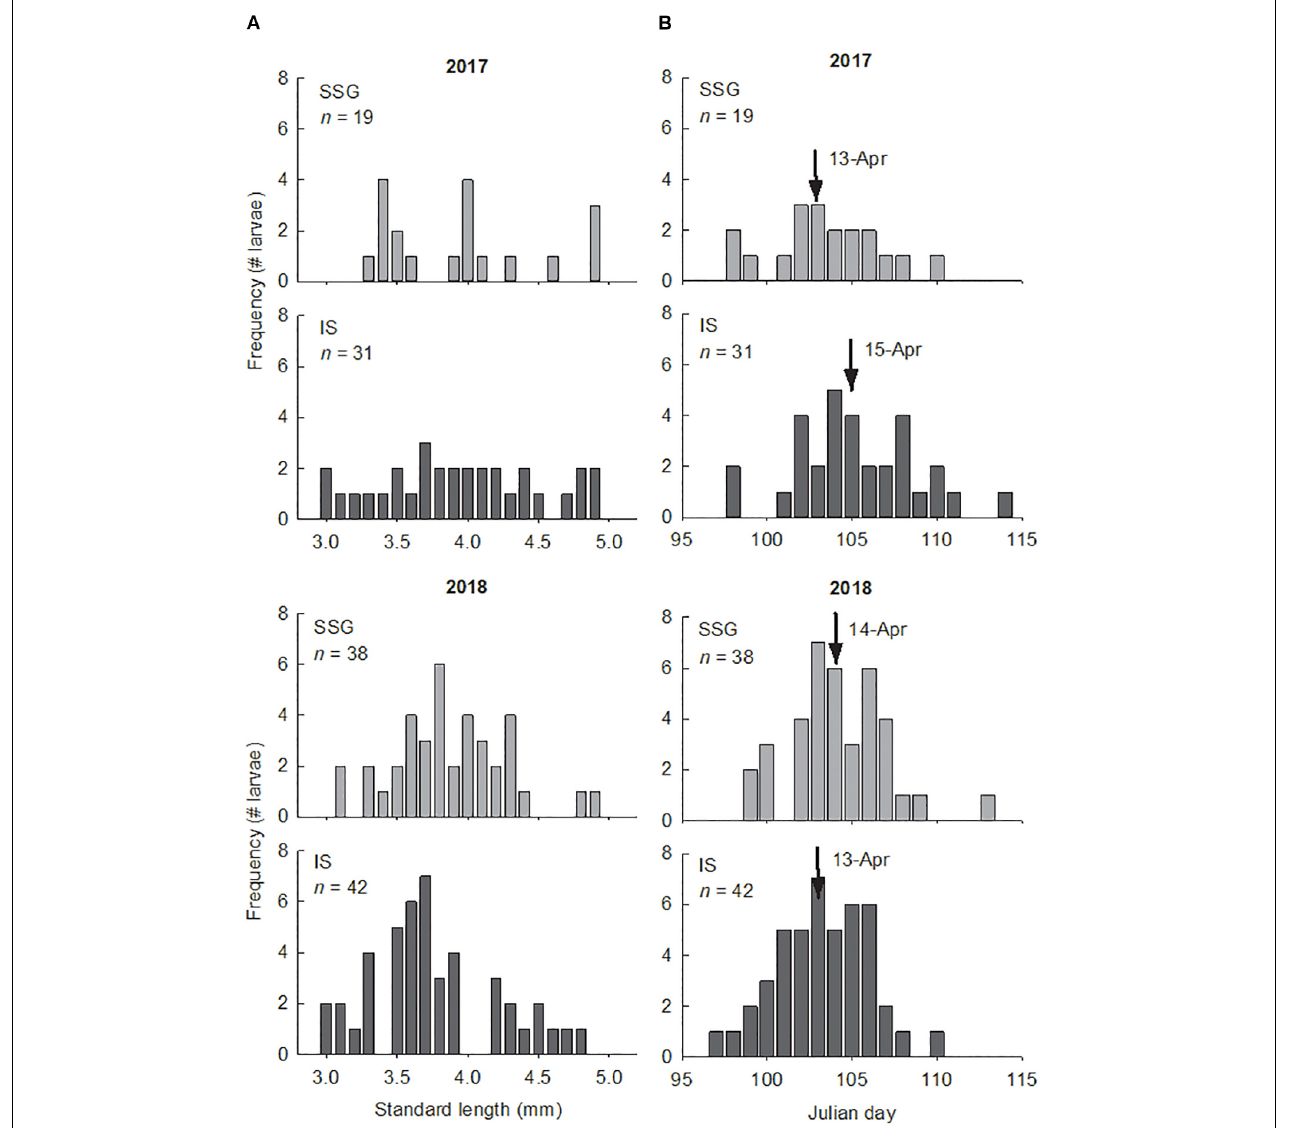
FIGURE 7 | (A) Length frequency distributions of King George whiting larvae from Southern Spencer Gulf (SSG) and Investigator Strait (IS) in 2017 and 2018. Size was constrained to larvae of ≤ 5 mm SL. (B) Frequency histograms showing the number of aged larvae that hatched on the nominated Julian day in 2017 and 2018. Arrows identify the mean hatch